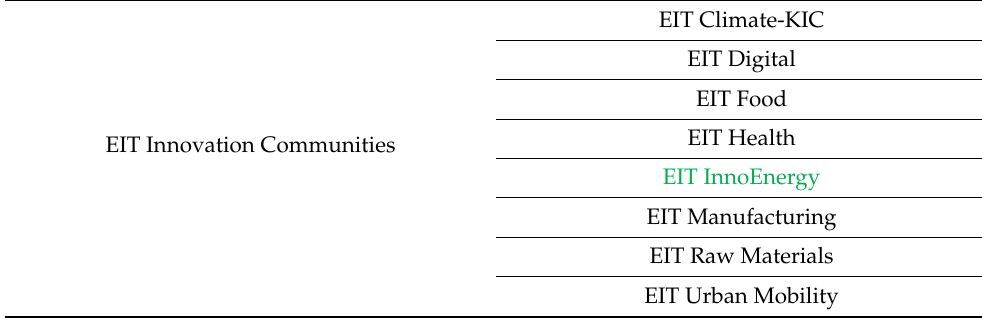
Table 2. EIT Innovation Communities structure (source: own elaboration, based on: www.eit.europa. eu, accessed on 2 September